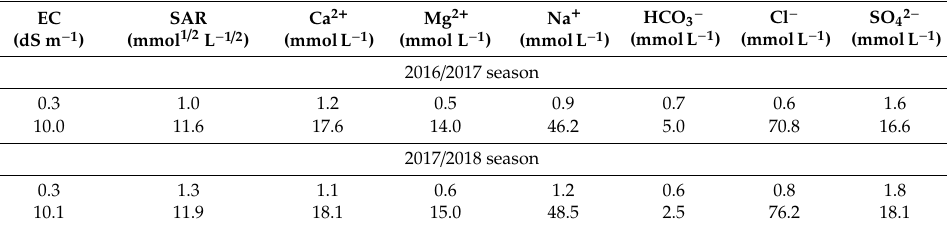
Table 2. Average quality of irrigation water during 2016 / 2017 and 2017 / 2018